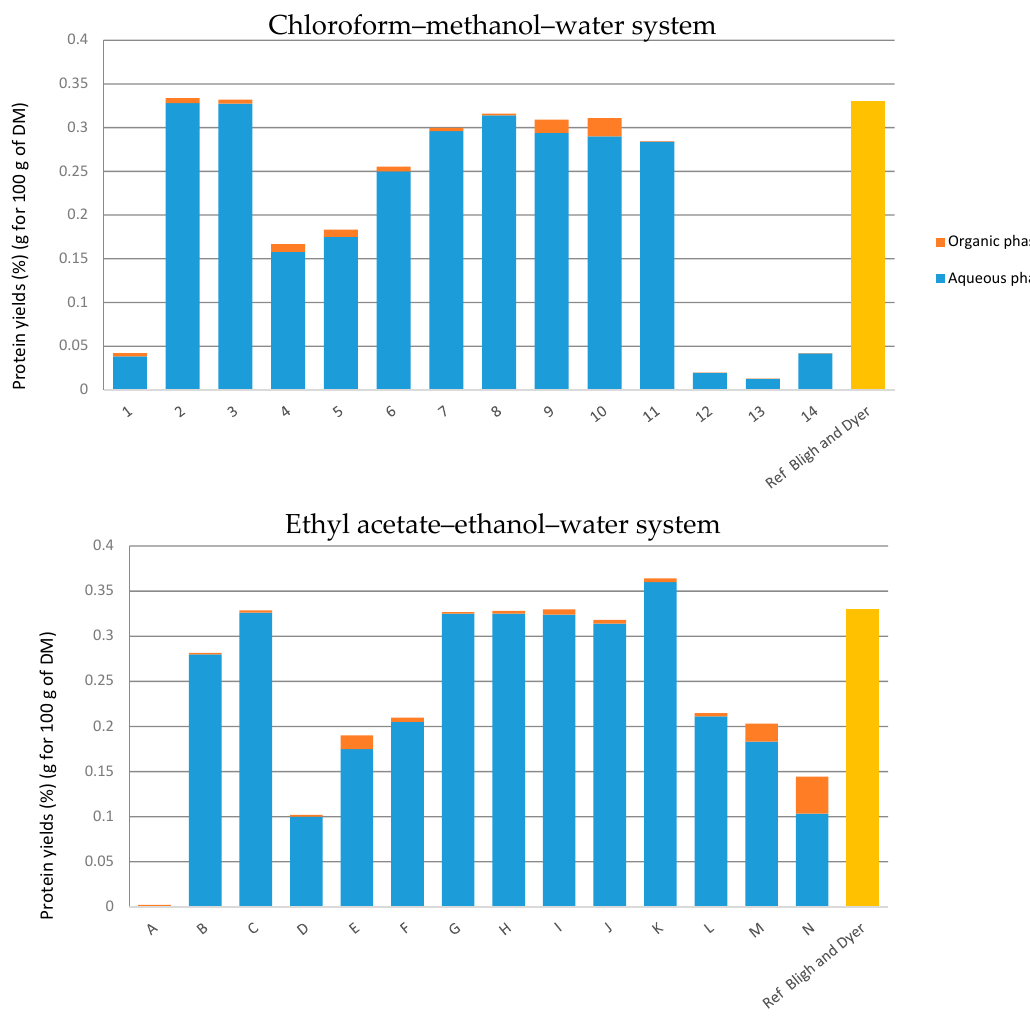
Figure 5. Extraction yields of proteins in both systems. Yields obtained by UV spectrometry in aqueous and organic phases. Points 1 to 13 are in the diagram with the classical solvents and points A to N are in the diagram with the green alternative solvents. The orange part is the organic phase and the blue part is the aqueous phase.